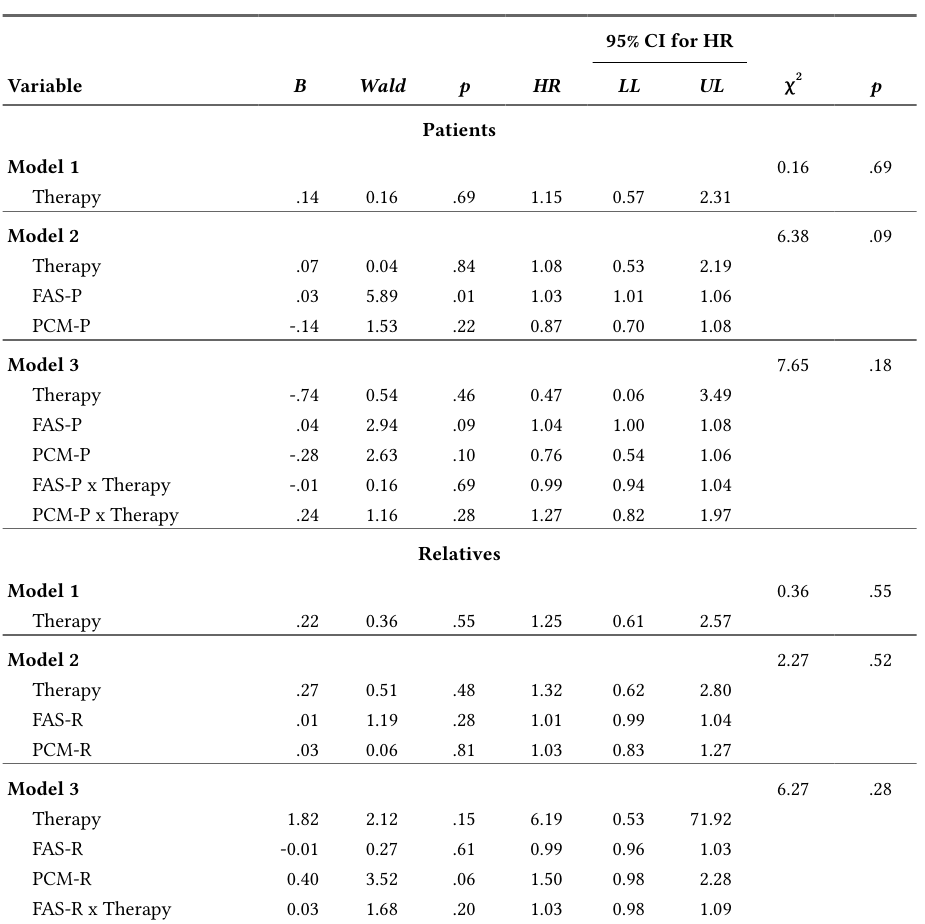
Cox Proportional Hazards Models Testing FAS and PCM as Predictors of Depressive Recurrence